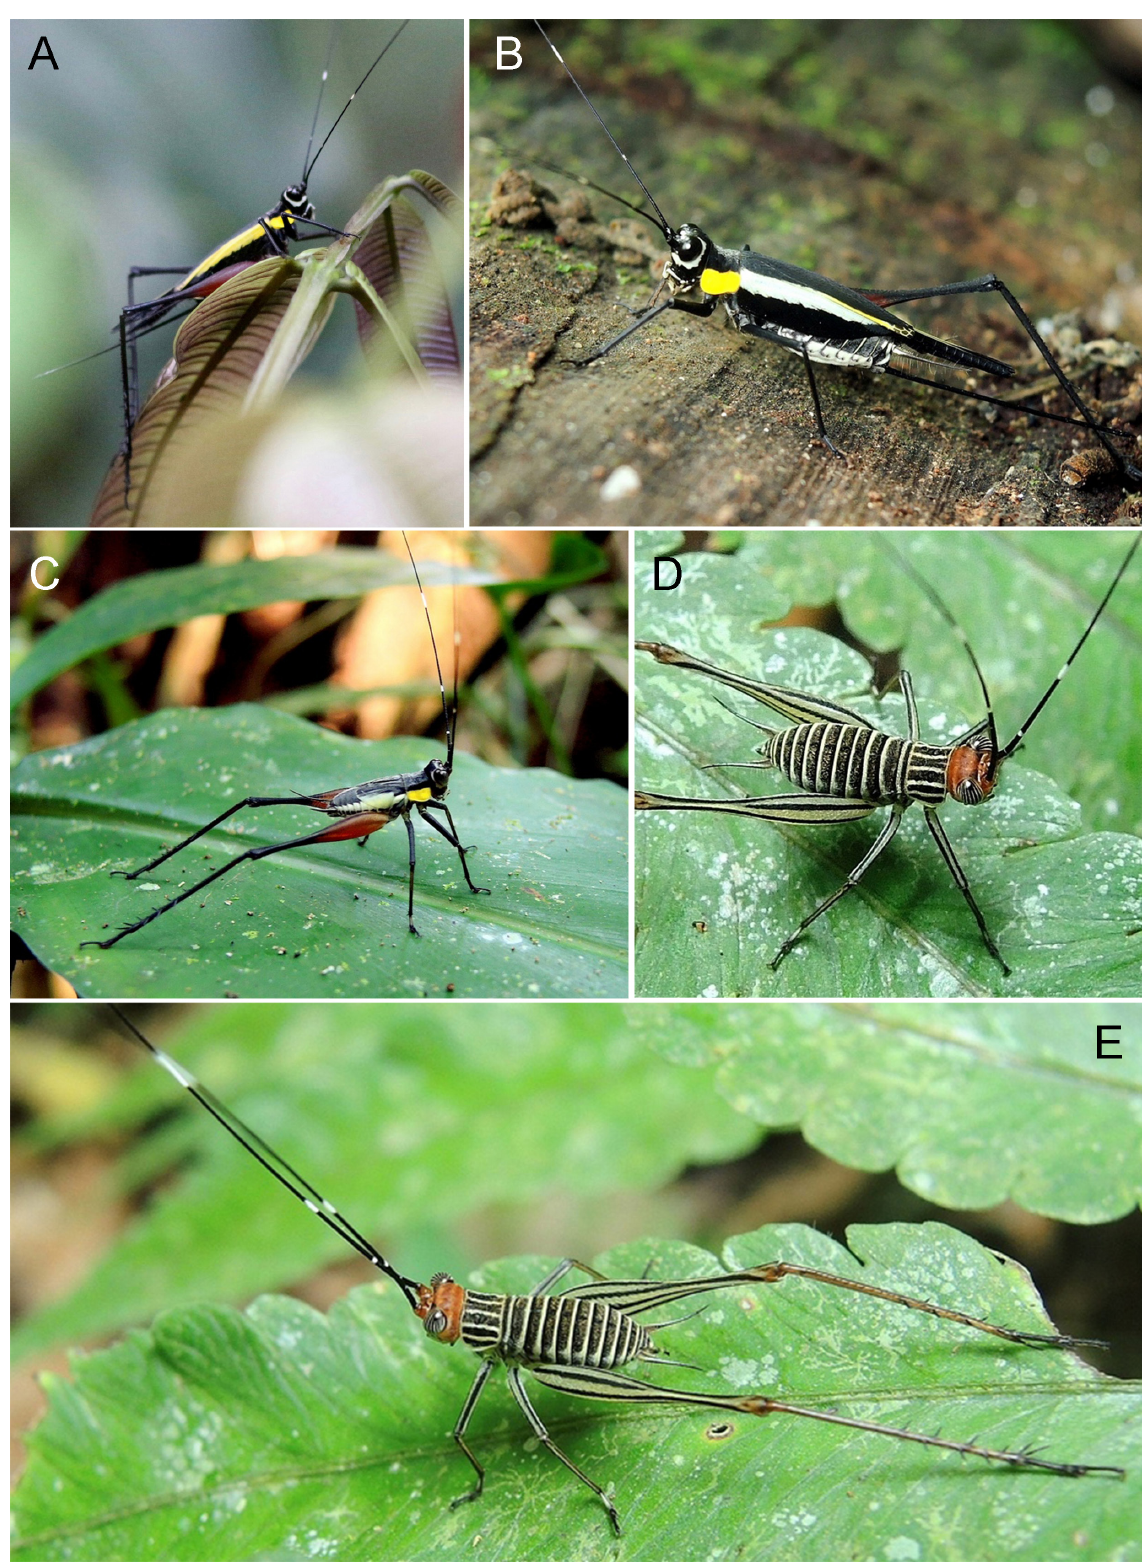
Fig. 20. Nisitrus hughtani Robillard & Tan sp. nov. in its natural environment in West Sumatra. A–B . Adult ♀♀. C–E . Juveniles. Photograph source and credits: iNaturalist; Oscar Johnson (A), Michael Kesl